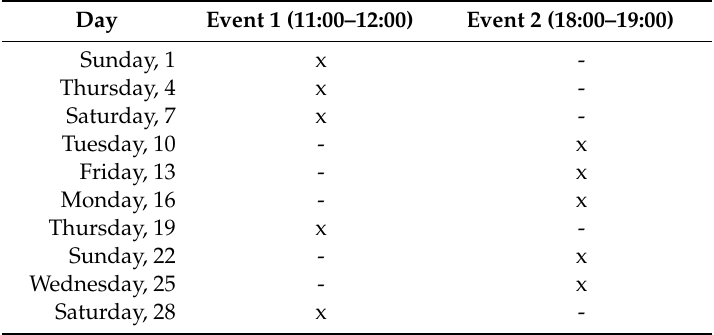
Table 5. DR (Demand Response) events.